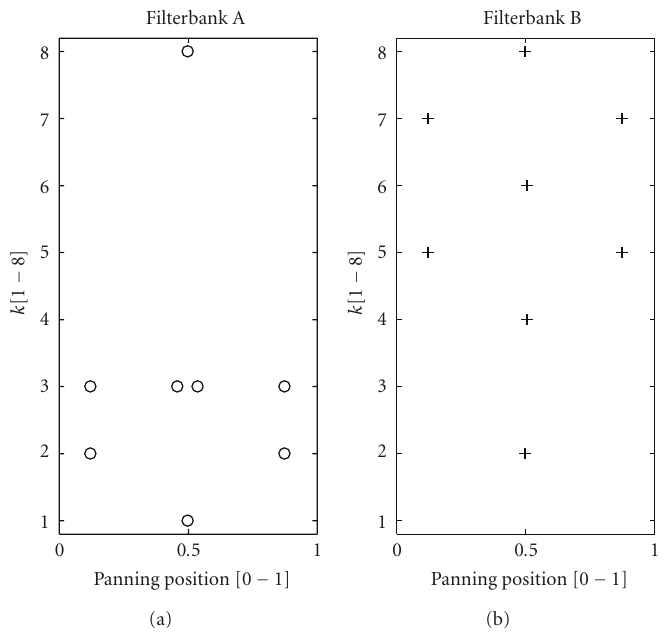
Figure 9: Distribution of sources among filters for methods A and B for the same song ( P W = 0 . 059).